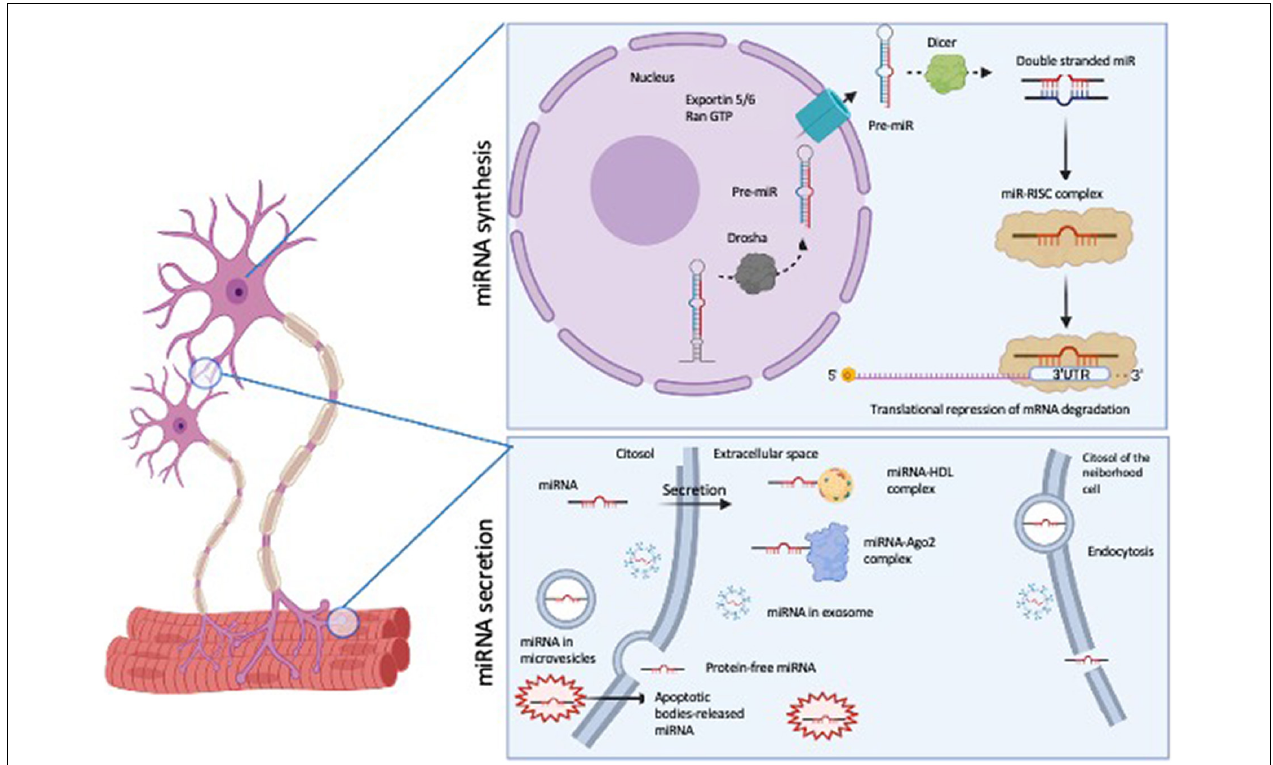
FIGURE 1 | Schematic representation of miRNA biosynthesis and secretion pathways. The figure was generated by BioRender software